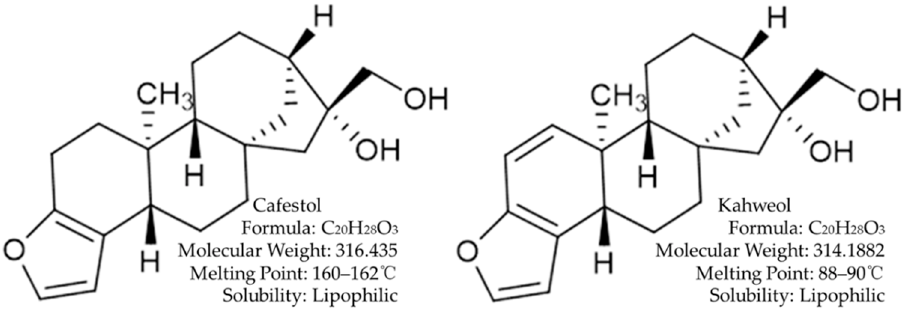
Figure 1. Structure and chemical characteristics of cafestol and kaweol. They are natural diterpenes extracted from coffee beans. 14